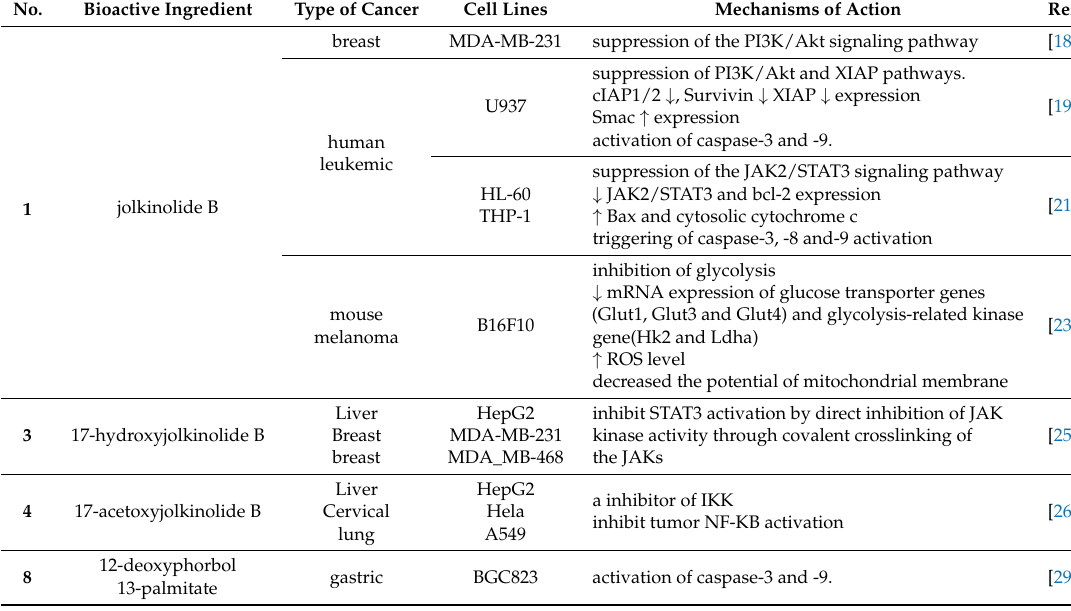
Table 4. Mechanisms of diterpenoids in inducing apoptosis.